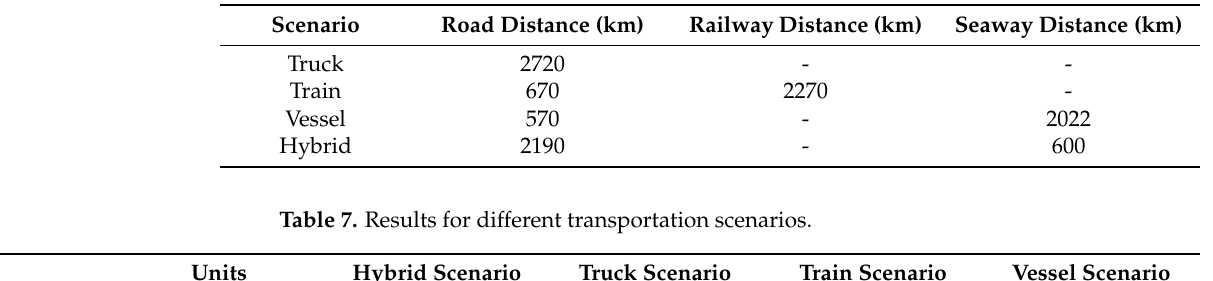
Table 6. Transportation distance.